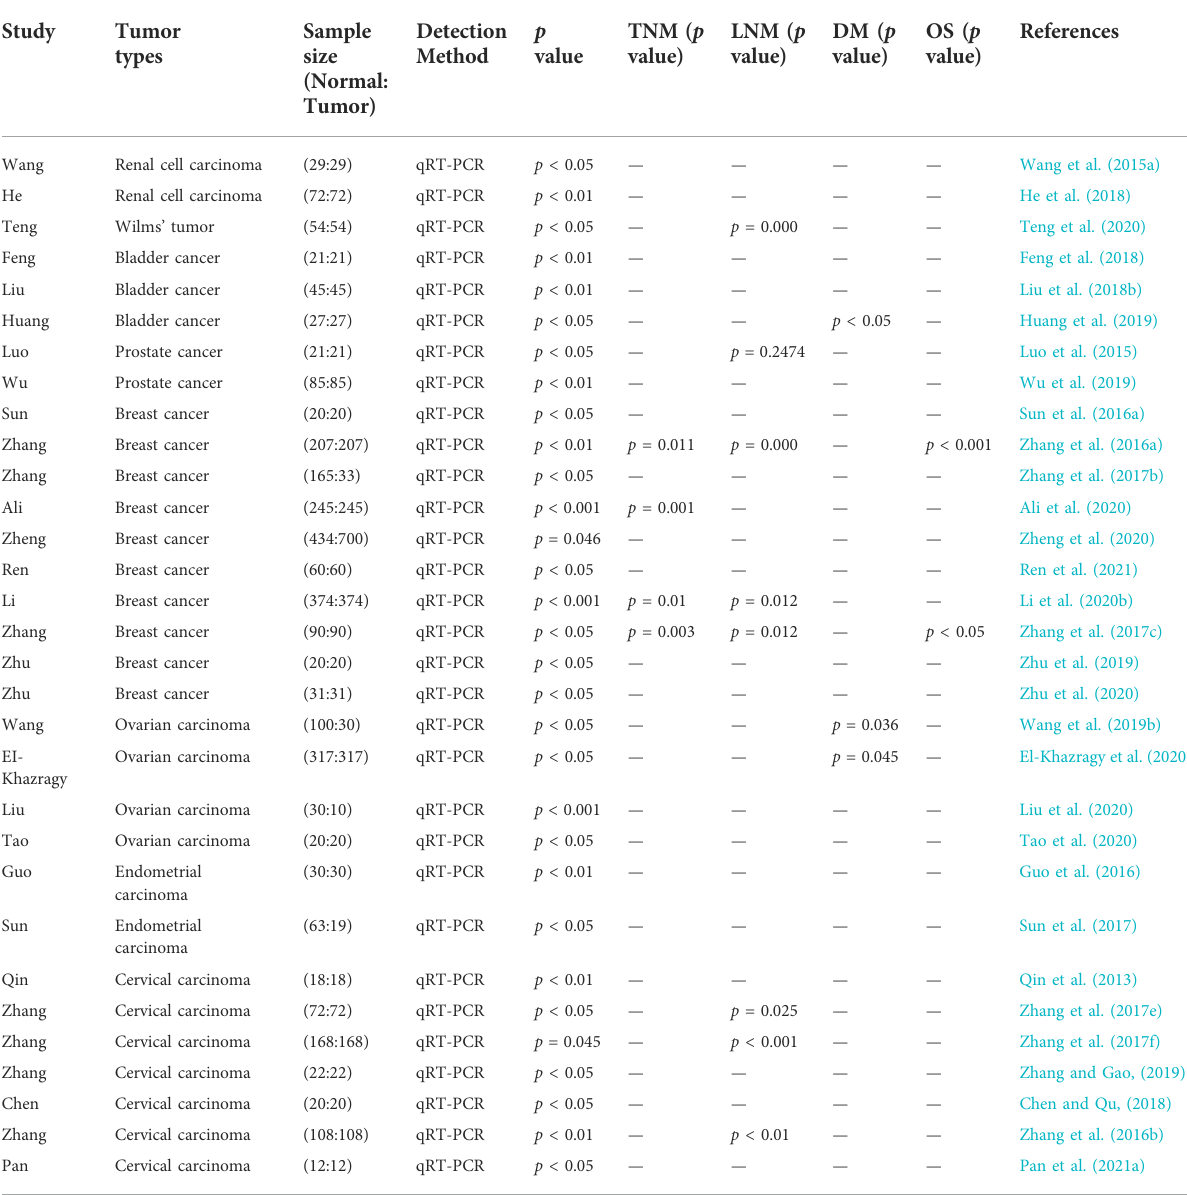
TABLE 4 Features of the studies included in this review of genitourinary system